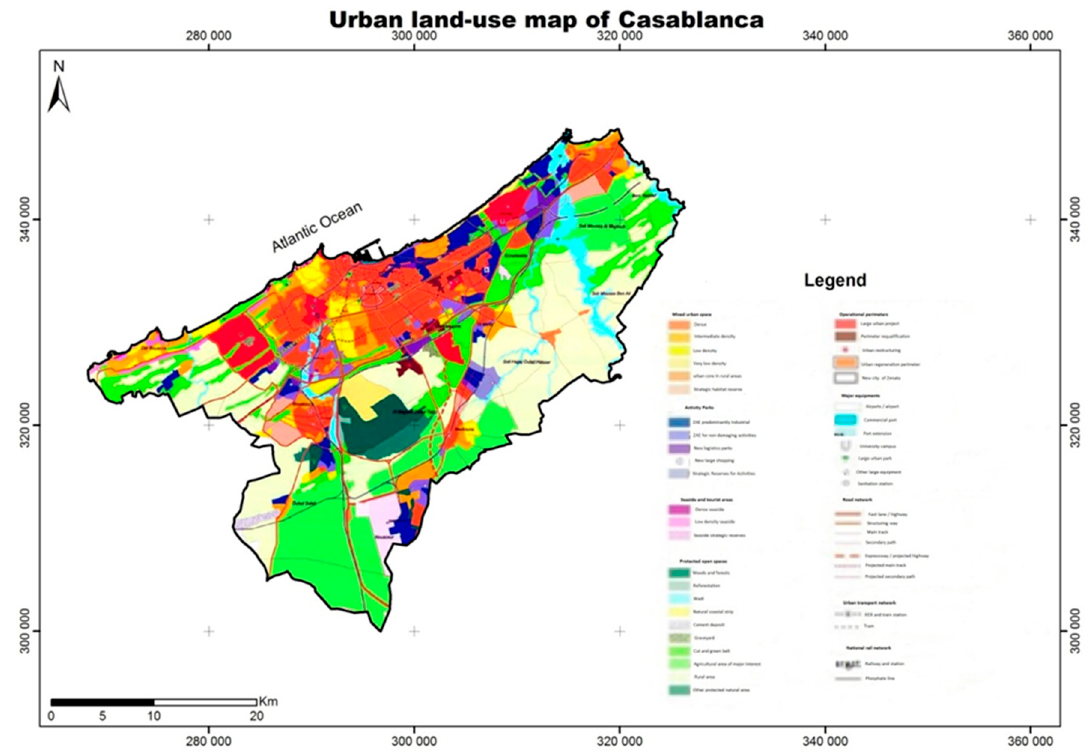
Figure 9. The urban land-use map of Casablanca.